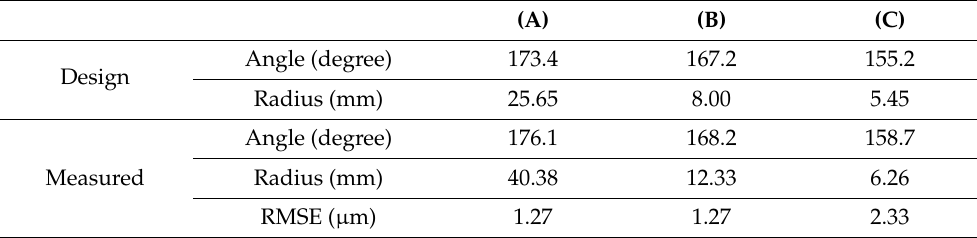
Table 6. Comparison between design and measured values. The three cases, (A), (B) and (C) are graphically presented in Figure 10.